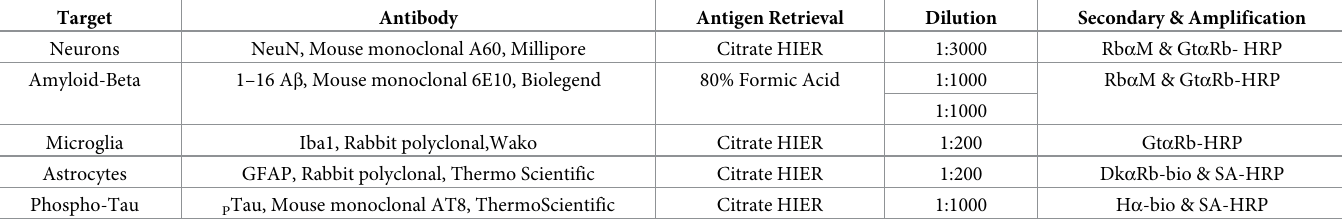
Table 1. Primary and amplification antibodies used for